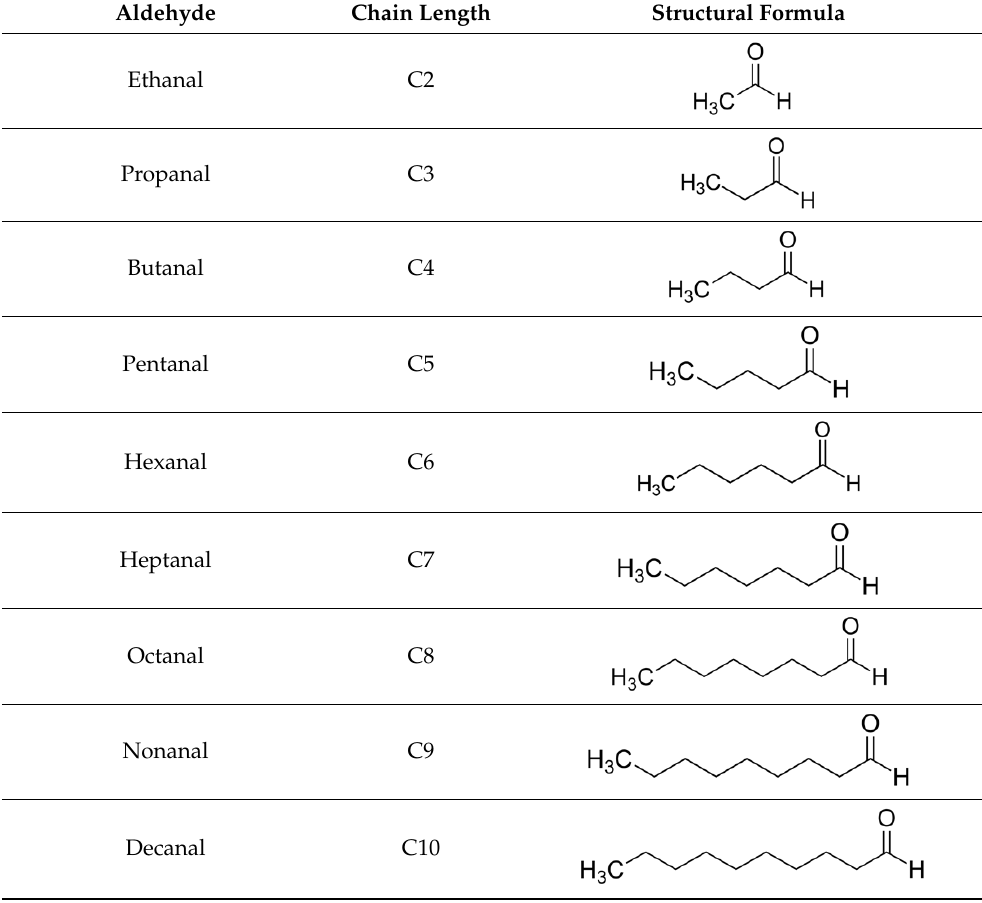
Table 1. Overview of straight-chain aliphatic aldehydes. Aldehyde Chain Length Structural Formula